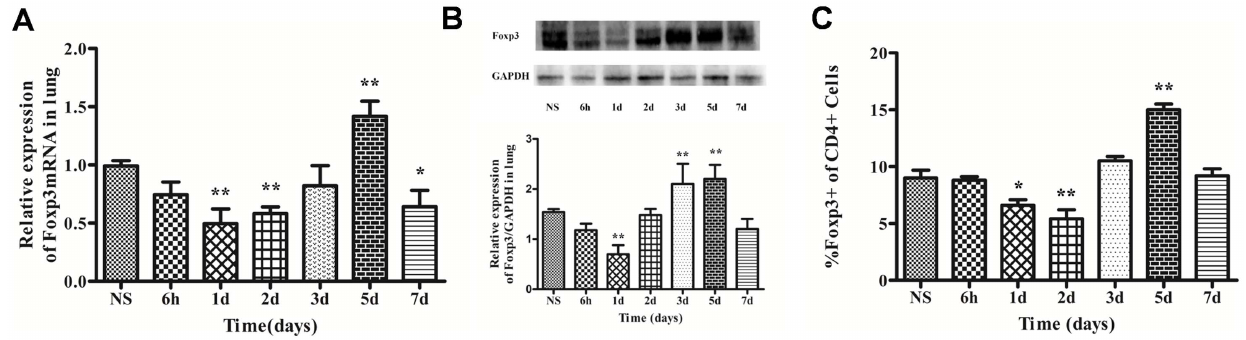
Figure 3. The Foxp3 mRNA expression level and the Foxp3 protein level in the lung tissues and flow cytometry analysis of the Treg cells in the spleen. Expression level of Foxp3 mRNA (A), Western blot of Foxp3 protein level (B) and flow cytometry of Treg cells (C). The values show the means 6 SEM (n=6 for each group). * P , 0.05 compared with the NS-treated group; ** P , 0.01 compared with the NS-treated group.